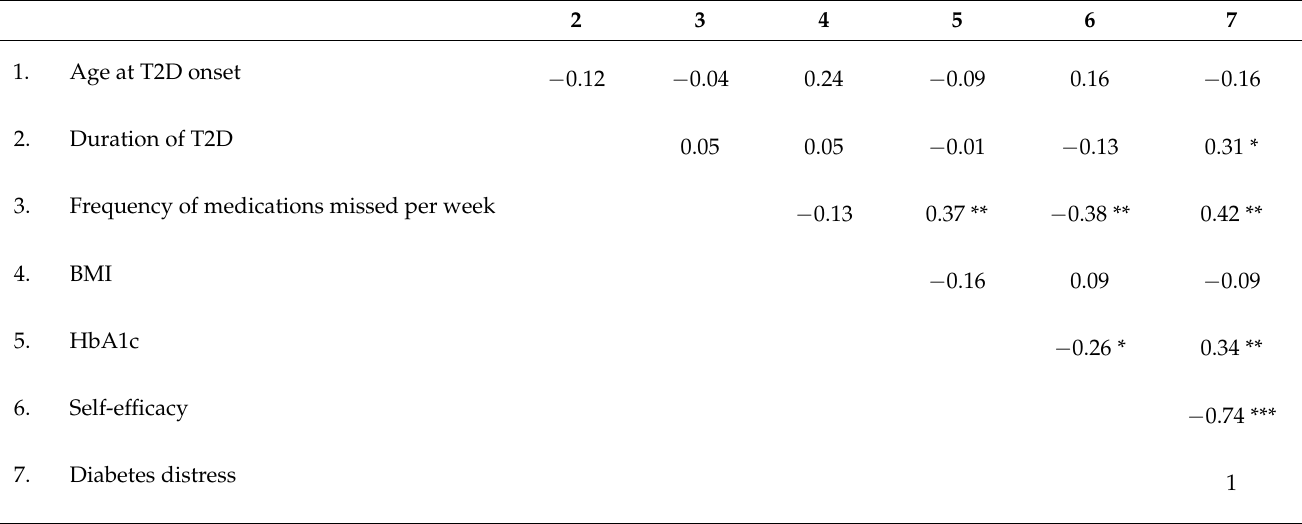
Table 2. Bivariate correlations of study variables (N = 60).